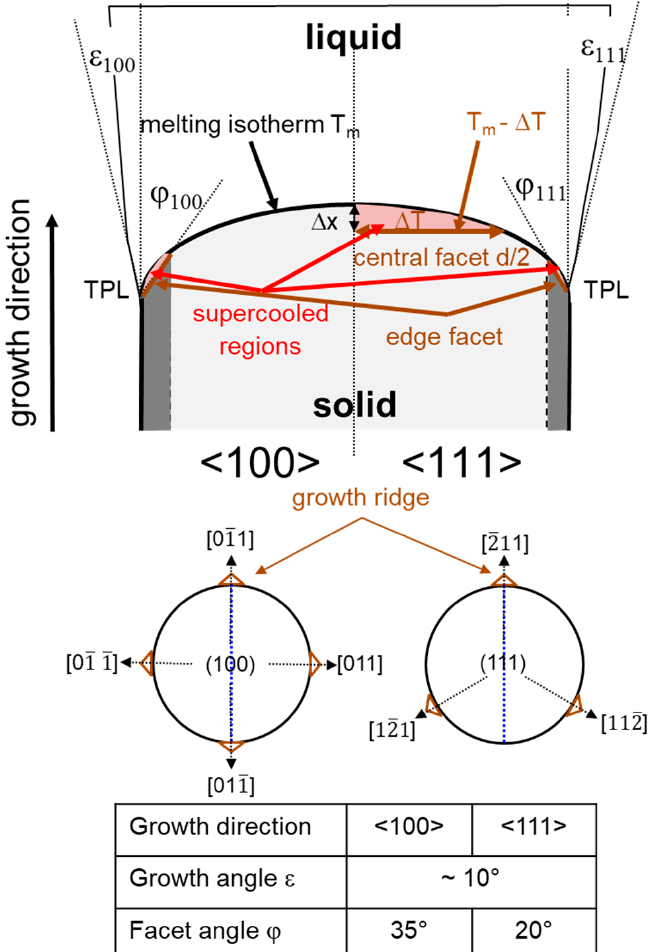
Figure 2. Upper part: Schematic representation of interface shapes during growth of Si by the Floating Zone or Zone Melting technique. (Note: For Cz configuration, the growth direction is opposite, and the whole sketch has to be mirrored at the horizontal axis). ( left ) Convex shape and rough interface for the <100> crystal orientation; ( right ) convex shape and central facet with a facet length d for the <111> crystal orientation. The edge facets which form at the triple point (TPL) at the periphery of the crystal are shown for both cases. The distance ∆ x of the central facet to the curved melting point isotherm T m at the symmetry axis is a measure of the maximum supercooling Δ T. Lower part: cross sections of the Si crystals perpendicular to the growth direction. The edge facets are visible as protrusions on the crystal surface along the <011> direction for the <100> crystal orientation, and along the <211> direction for the <111> crystal orientation. The blue dotted line marks the target cross section for the sample preparation in this work.